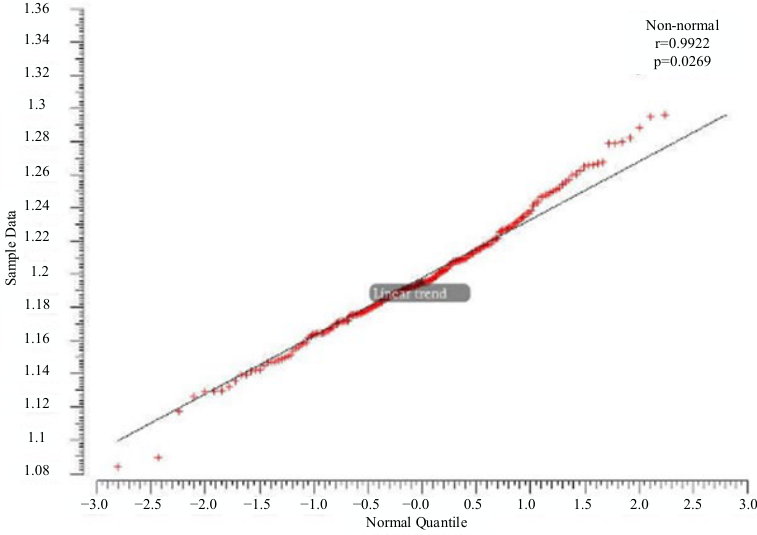
Figure 10. Normal quantile plot of the proposed BGR circuit.